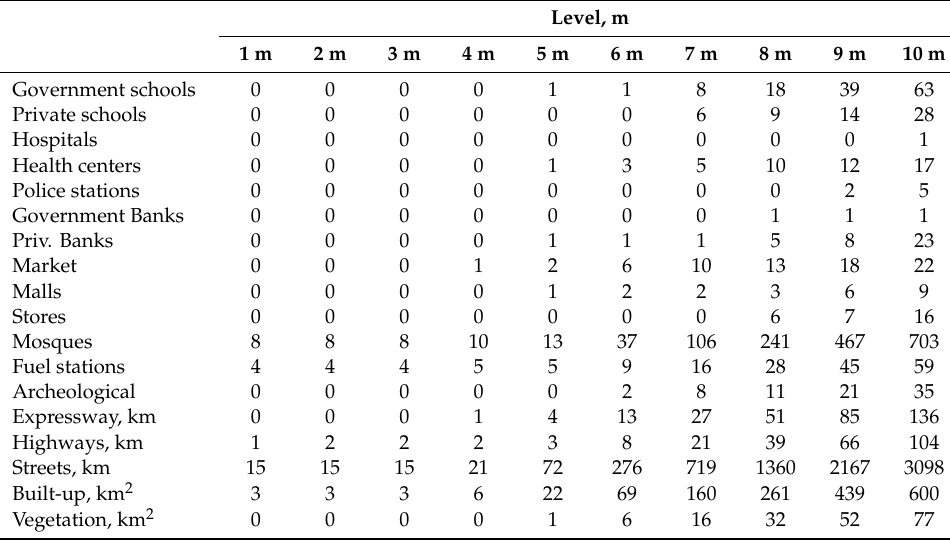
Figure 4. The distribution of the four elevated coastal zones in Oman as extracted from the GDEM. Table 3. The infrastructure/elevation matrix for Oman.